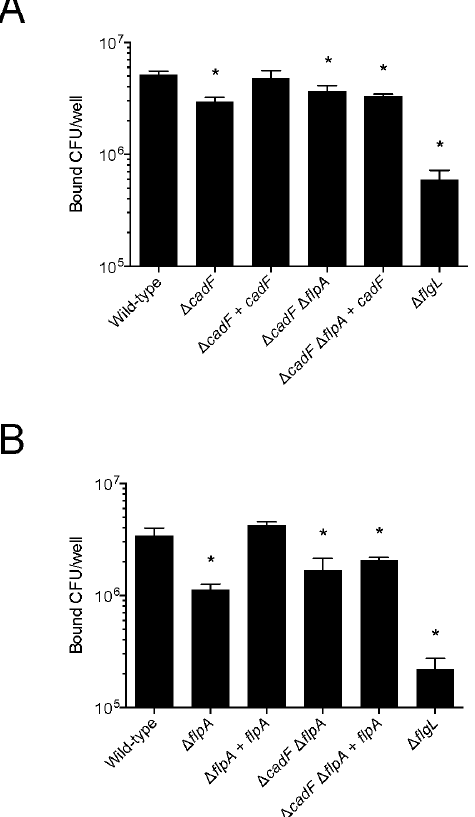
Figure 5. C. jejuni adherence to INT 407 cells requires both CadF and FlpA. In vitro adherence assays were performed with human INT 407 epithelial cells and the C. jejuni 81-176 wild-type strain, C. jejuni ∆ cadF and ∆ flpA mutants, and complemented strains as outlined in the “Materials and Methods” section. ( A ) Transformation of a C. jejuni ∆ cadF mutant ( ∆ cadF :: cadF NP -FLAG) but not the ∆ cadF ∆ flpA mutant restores binding to the level observed with the wild-type strain. ( B ) Transformation of a C. jejuni flpA deletion mutant ( ∆ flpA ) but not the ∆ cadF ∆ flpA mutant restores binding to the level observed with the wild-type strain. Values represent the number of adherent bacteria ± standard deviation. The asterisks indicate that the number of bacteria bound to the INT 407 cells was statistically di ff erent (* p < 0.05) from that of the C. jejuni wild-type strain, as judged by one-way ANOVA followed by Dunnett’s multiple comparisons test.